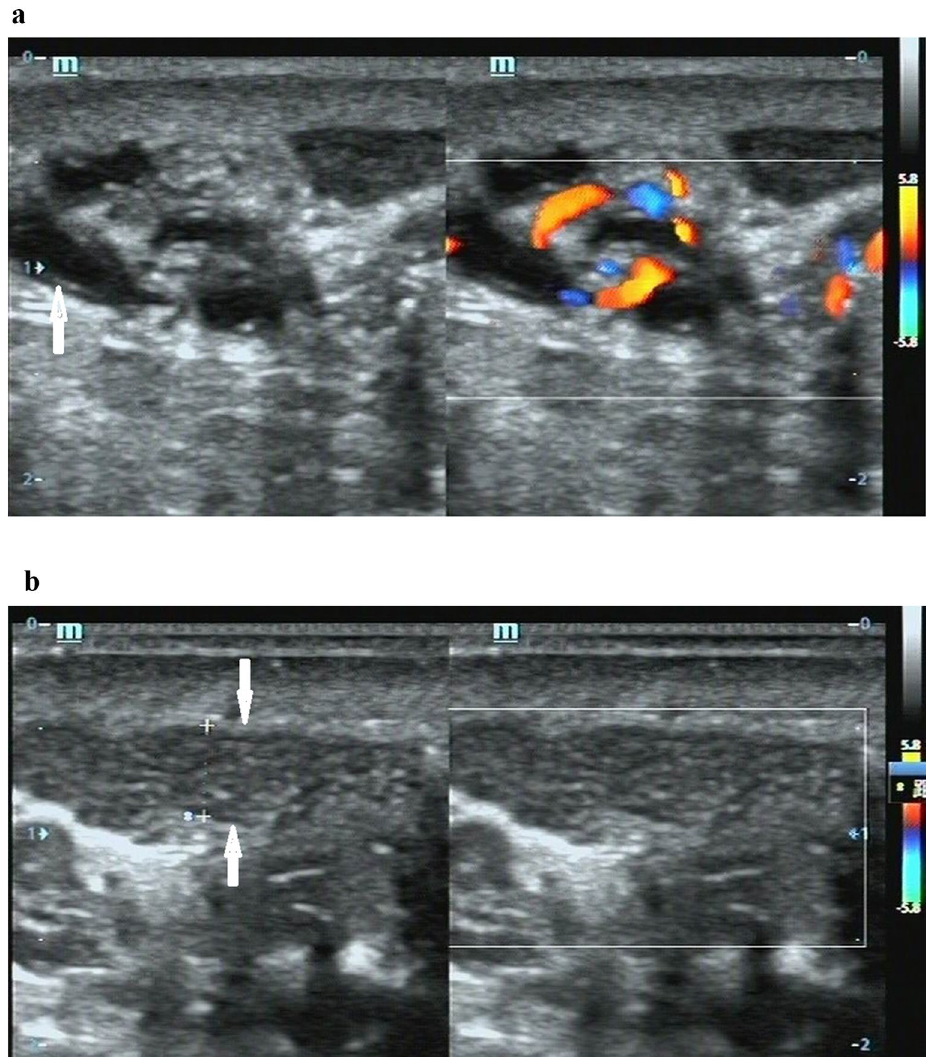
region on duplex ultrasound at standing position with Valsalva maneuver, and the wall of the tubular structures is thicker than that of the pampiniform vein (arrow, a ); the left epididymis present multiple thin tubular structures without color Doppler flow signal (arrows, b